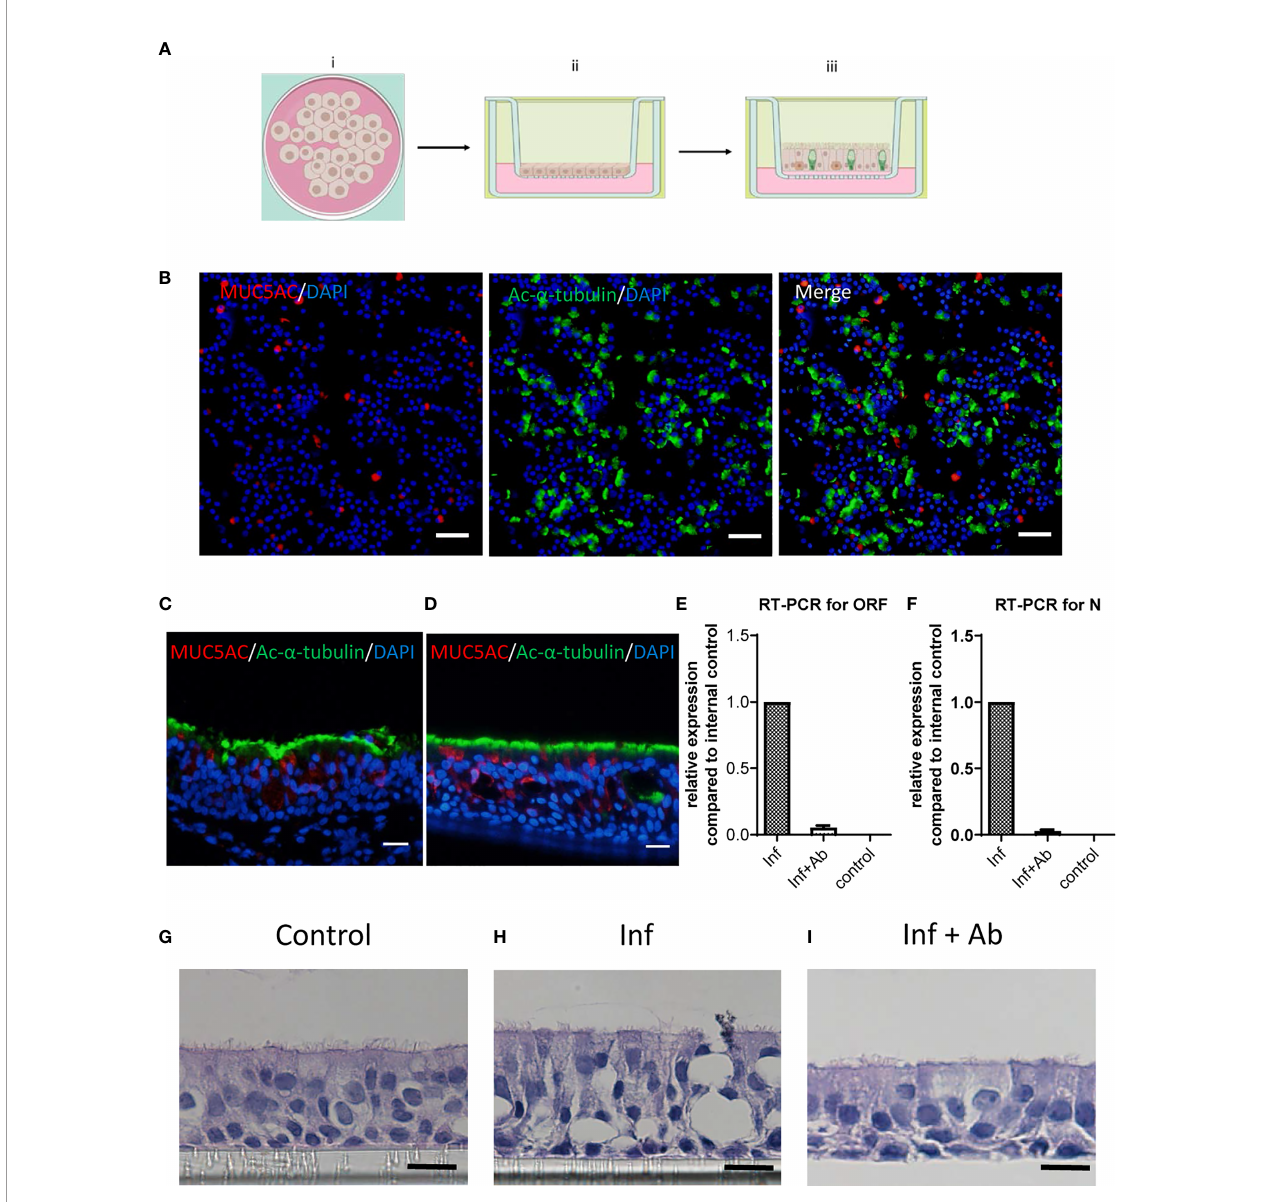
FIGURE 3 | Infection on differentiated human bronchial epithelial cells (HBECs). (A) Schematic representation of air – liquid interphase (ALI) culture conditions and differentiation. (B) Immuno fl uorescence staining of differentiated HBECs revealing Ac- a -tubulin stained in ciliated cells (green), goblet cells stained with MUC5AC (red), and the 4',6-diamidino-2-phenylindole (DAPI)-represented nucleus (blue). Scale bar: 50 m m. (C, D) Immuno fl uorescence staining of (C) bronchial biopsy and (D) cultured HBECs with ciliated cells stained with Ac- a -tubulin (green) and goblet cells stained with MUC5AC (red). Scale bar: 20 m m. (E, F) RT-qPCR quanti fi cation of (E) ORF and (F) N domains of severe acute respiratory syndrome coronavirus 2 (SARS-CoV-2) in topical secretions. (G – I) H&E images revealing (G) the tissue integrity of the mock-infected control (Control), (H) tissue damage following SARS-CoV-2 infection (Inf), and (I) the protected epithelium with anti-receptor-binding domain (RBD) polyclonal antibody (pAb) treatment after SARS-CoV-2 infection (Inf + Ab). Scale bar: 10 m